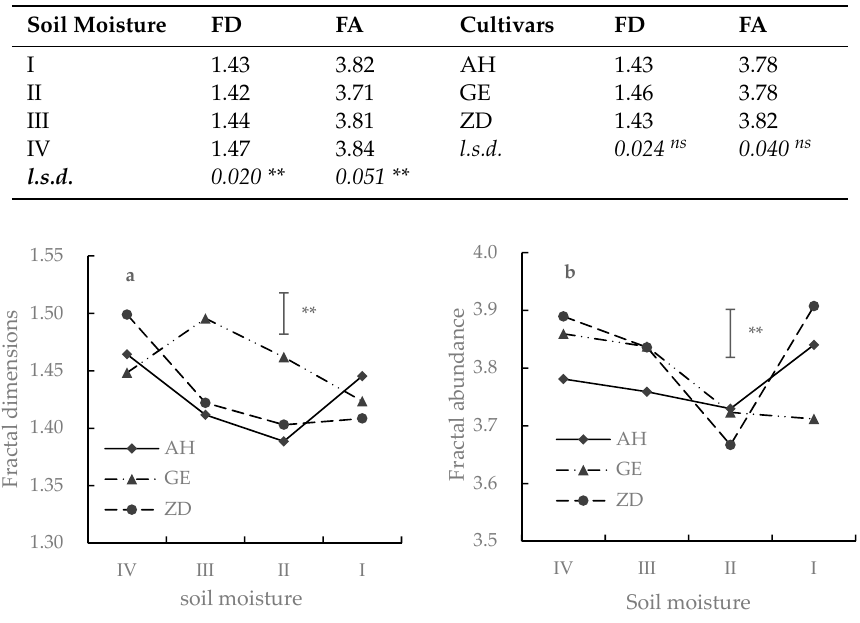
Figure 5. Interaction on ( a ) fractal dimension and ( b ) fractal abundances between cultivars (AH, GE